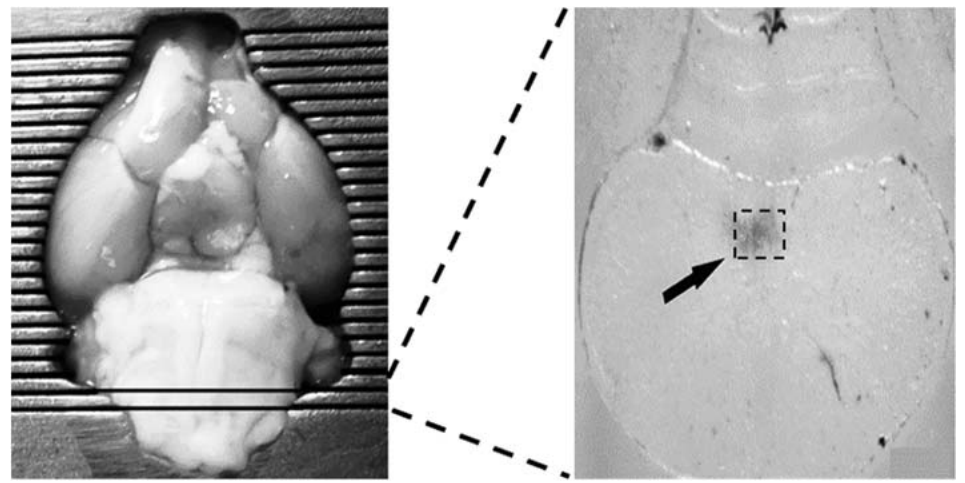
Figure 2. Dissection procedure for the NTS. The brain was sliced using a brain matrix and the cNTS microdissected from the indicated level as shown in the right panel.